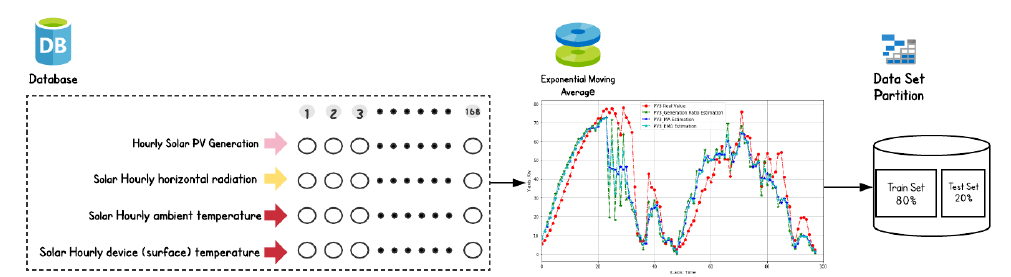
Figure 3. Data processing (training and testing procedures) of the proposed framework.